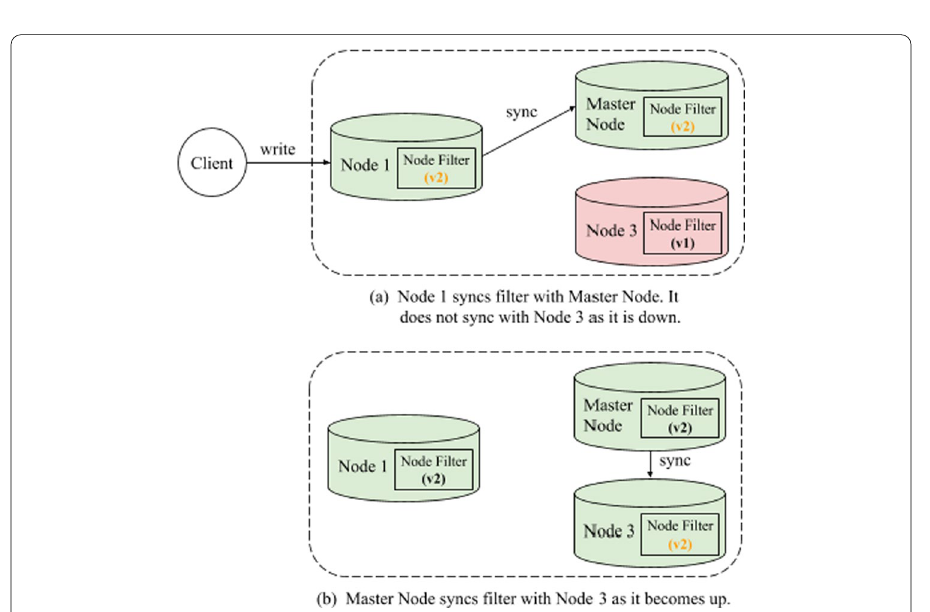
Fig. 20 Proper way to synchronize node filter in master-client distributed